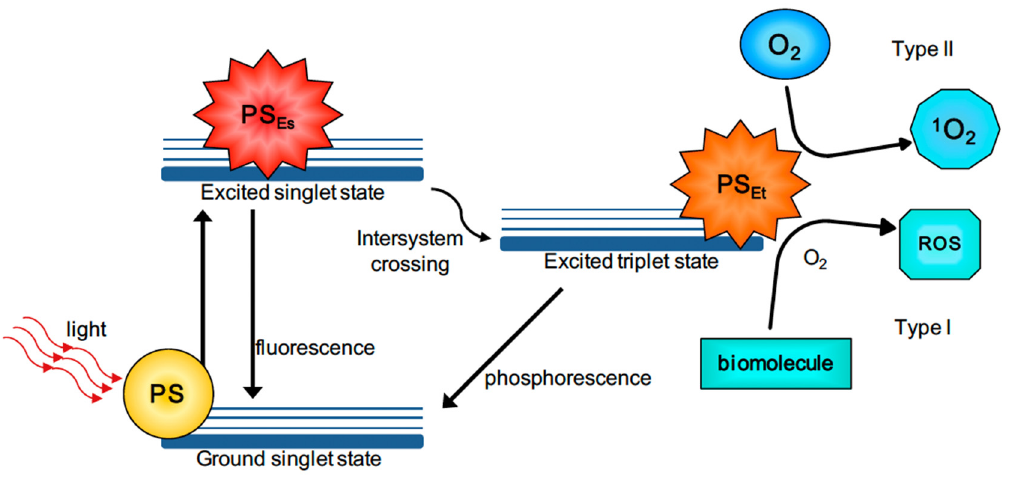
Figure 9. Reaction mechanism of PDT [115].